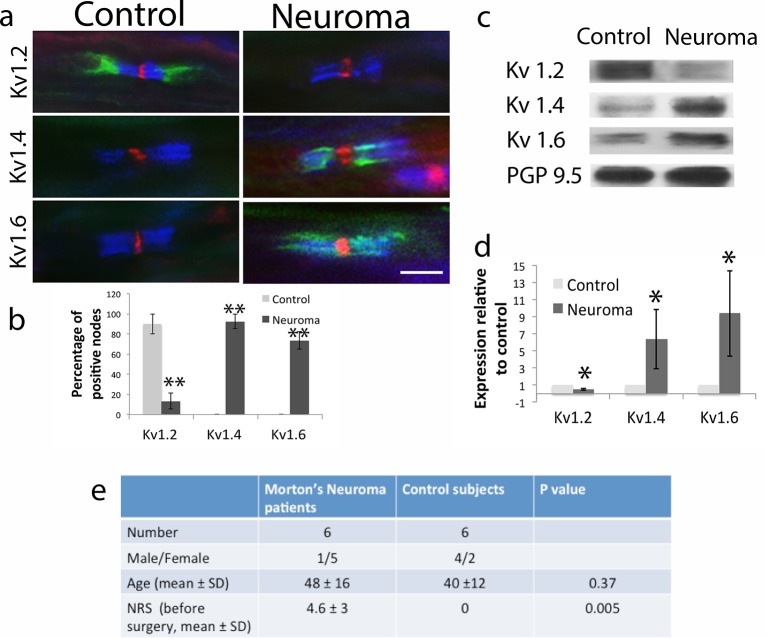
Kv1 channels expression in the sural nerve of healthy volunteers (control) and from patients with painful Morton neuroma.(a) Representative sections of longitudinal nerves immunostained with Kv1 channels in green (Kv1.2, Kv1.4 and Kv1.6 respectively), a panNav antibody in red (to identify the node), and caspr in blue (to identify the paranode). Kv1.2 is expressed in the juxtaparanode in control nerves but it is not present in the injured nerve. Kv1.4 and kv1.6 are not present in control nerve but are expressed in neuroma within the juxtaparanode and encroaching on the paranode nodes. (b) Quantification of the percentage of Kv1.2, Kv1.4, and Kv1.6 positive nodes in control and neuroma nodes (n = 3 per group, one way ANOVA). (c) Western blots showing expression of Kv1 channels in control and neuroma nerve. (d) Quantification of WBs (n = 6 per group, one way ANOVA). Kv1.2 is expressed in the control nerve and down regulated after axotomy, while Kv1.4 and Kv1.6 have a low/null expression in the control nerve and are up-regulated in neuroma. PGP9.5 was used as a loading control. Error bars denote (e) Patients and control subjects demographic data. The female/male ratio is different in patients with Morton neuroma and controls (patients with traumatic lesion of the hand) reflecting the F/M ratio of these different conditions. The mean age of patients with Morton neuroma is slightly higher than in control subjects, although it is not significant (t-test). All patients with Morton neuroma presented with pain (mean NRS 4.6), while control presented no pain in the area innervated by the sural nerve (Mann Whitney test). NRS: numerical rate score. Error bars denote SEM. Scale bars = 5 μm, **p<0.001, *p<0.05.DOI:
http://dx.doi.org/10.7554/eLife.12661.01510.7554/eLife.12661.016Figure 7—source data 1.Source data for Figure 7.